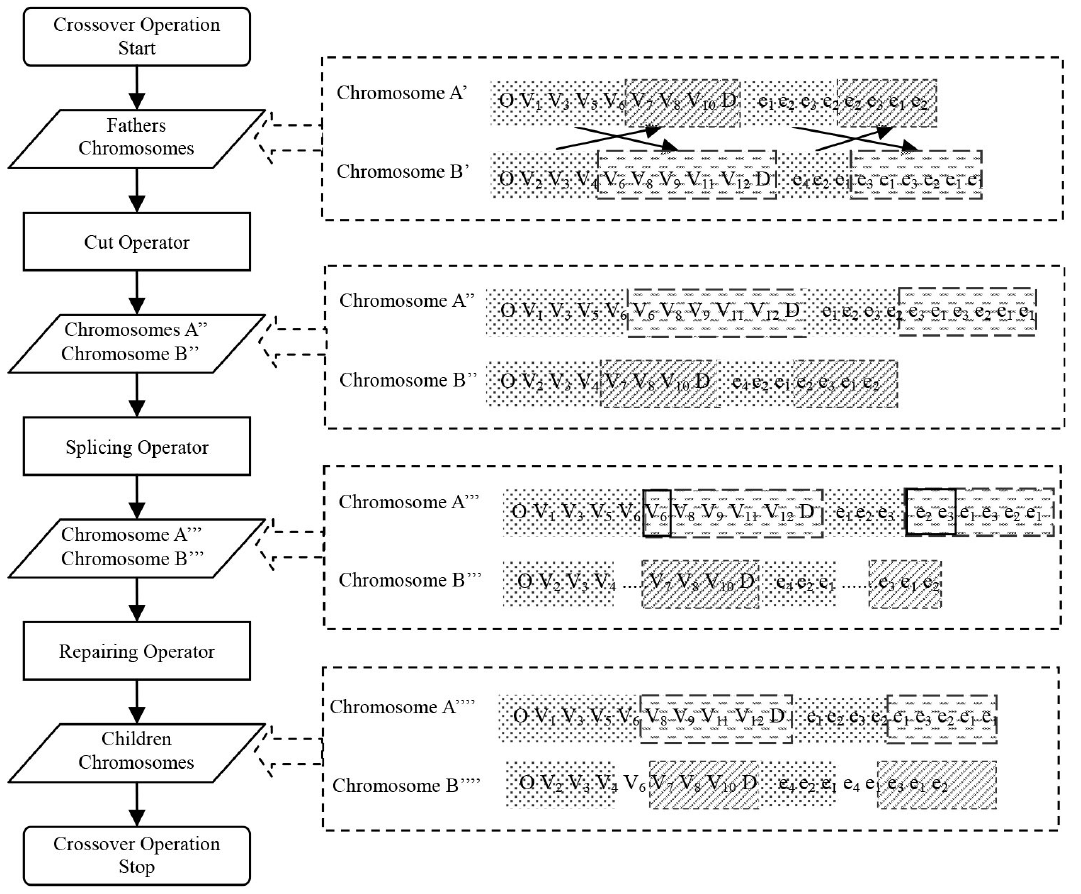
Figure 3. Crossover